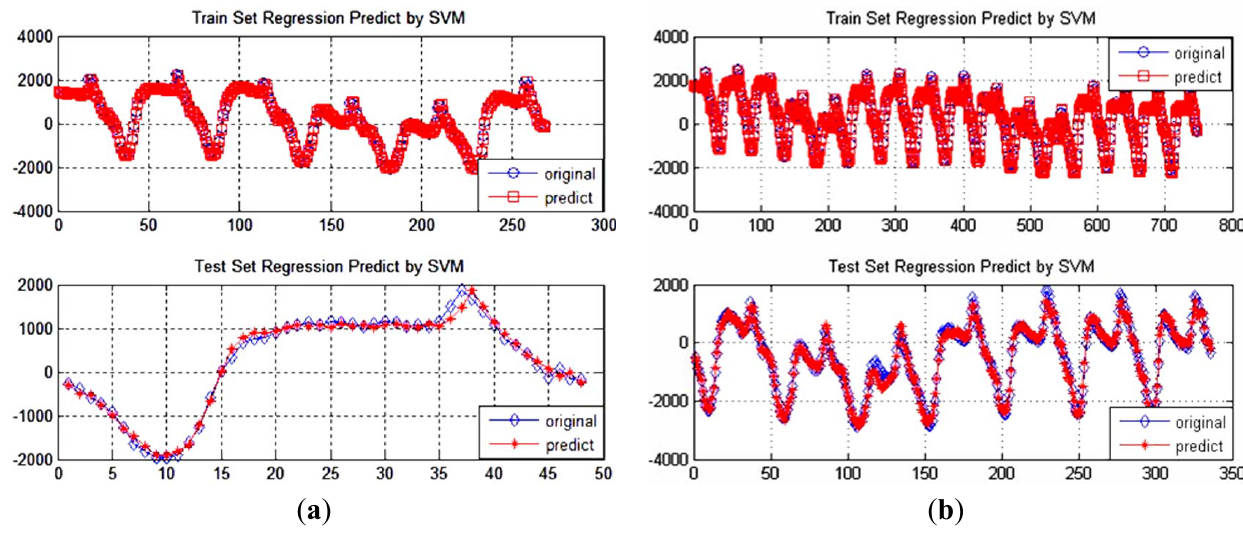
Figure 5. Comparison of the data-I and the forecasted electric load of train and test by the SVR model for the small sample and large sample data: ( a ) One-day ahead prediction of 8 May 2007 are performed by the model; ( b ) One-week ahead prediction from 18 May 2007 to 24 May 2007 are performed by the model.